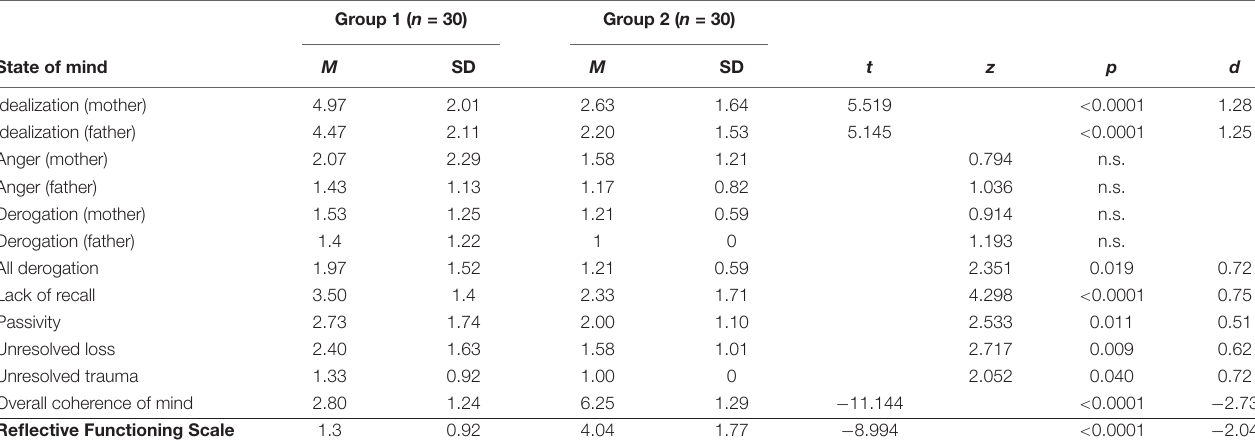
TABLE 3 | Descriptive statistics for AAI Scales for States of Mind and Reflective Functioning